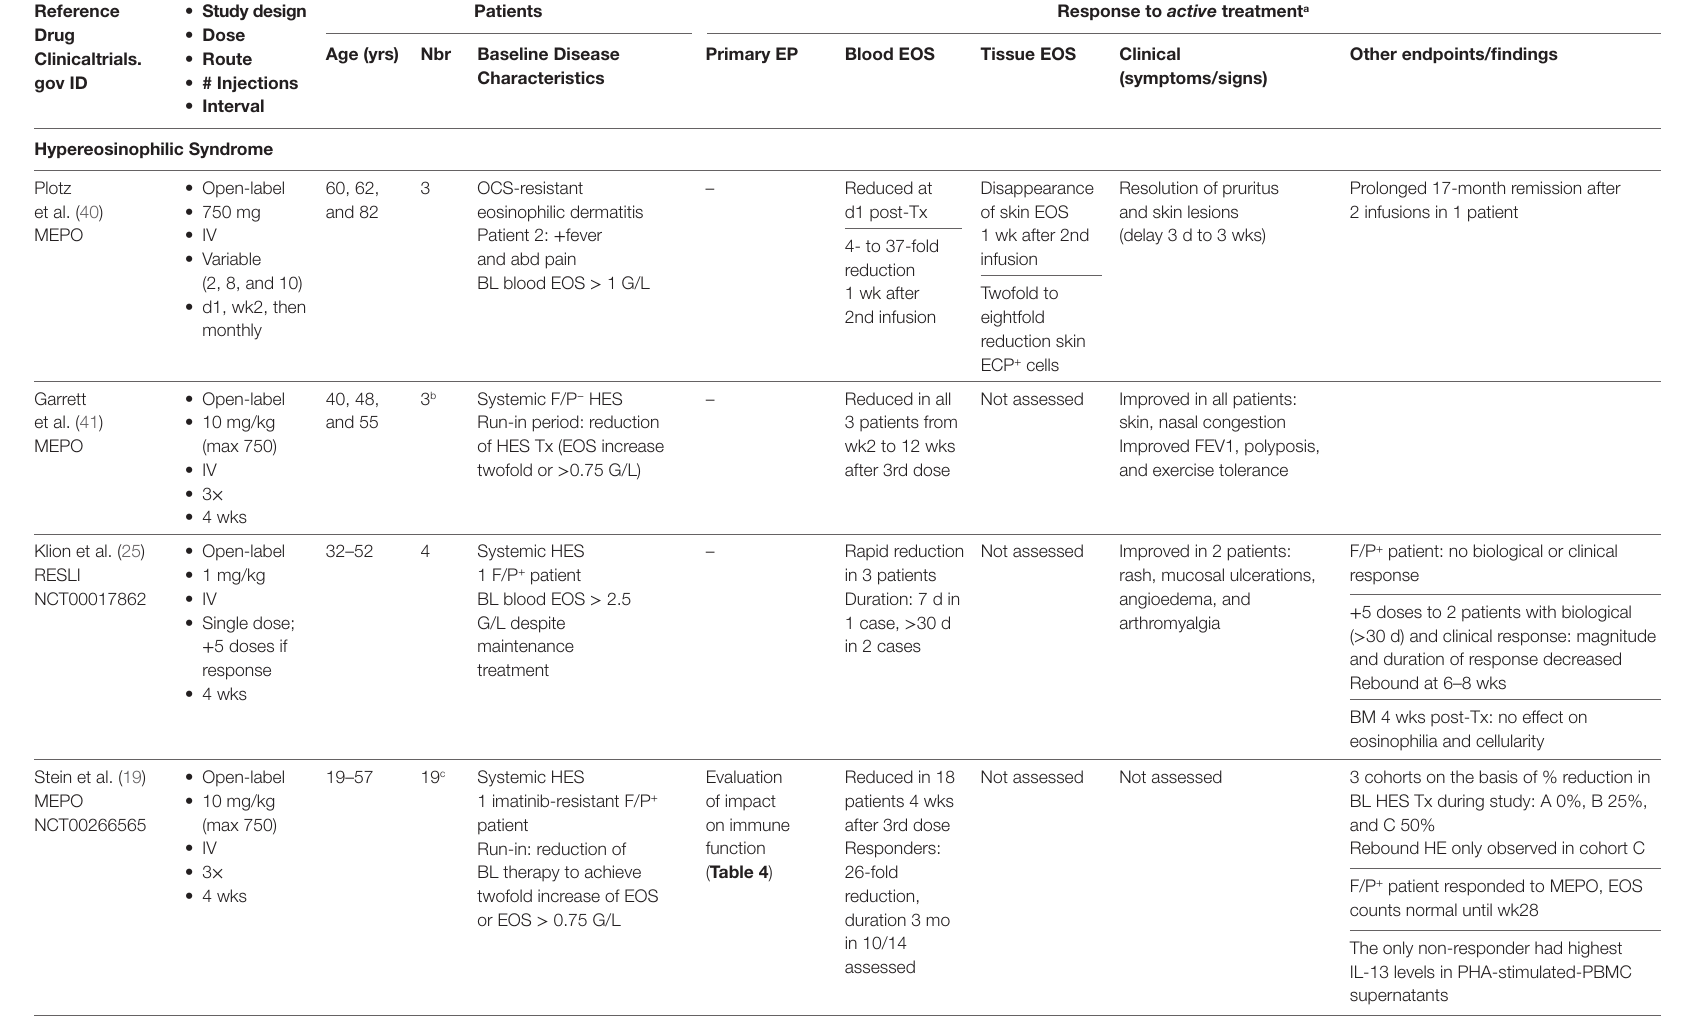
TABLe 3 | Clinical trials evaluating anti-IL-5 antibodies in systemic hypereosinophilic disorders. Reference